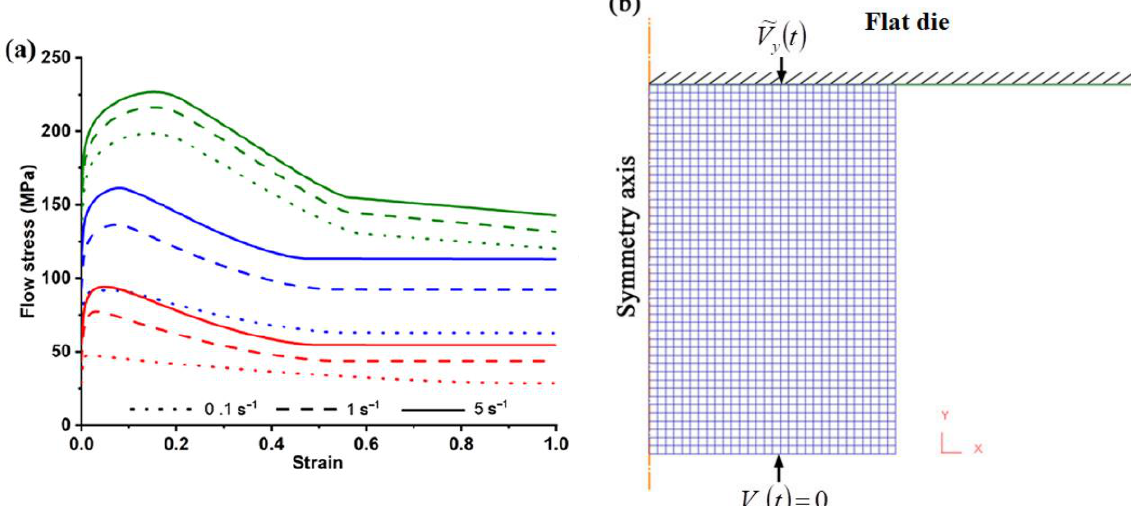
Figure 3. ( a ) Flow stress as dependent on strain for 300 ◦ C (green curve), 400 ◦ C (blue curve), 500 ◦ C (red curve), and strain rates ranging between 0.1 and 10 s −1 ; ( b ) the finite element grid used for the simulation.